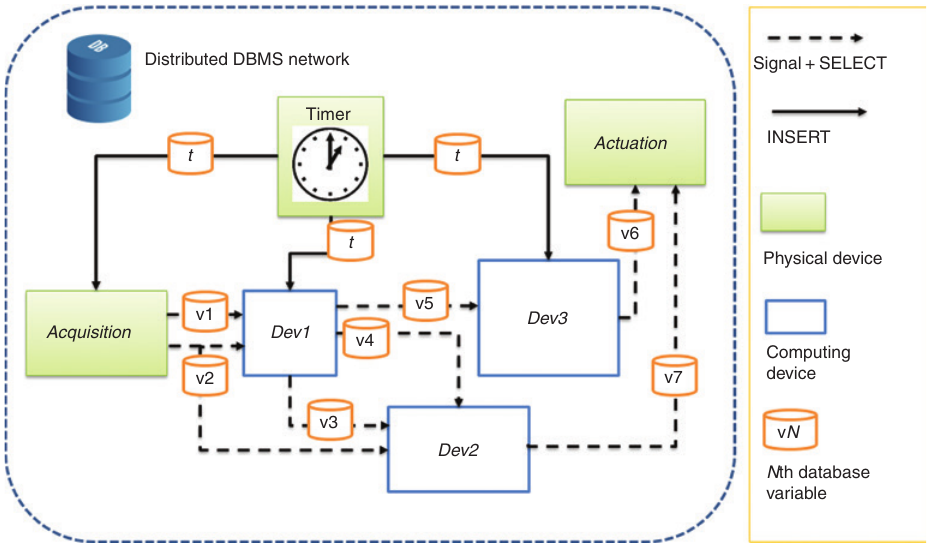
Figure 6: Device Network Over Distributed